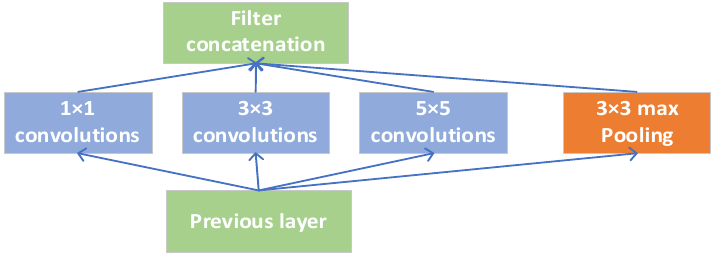
Figure 5. Naive Inception module.